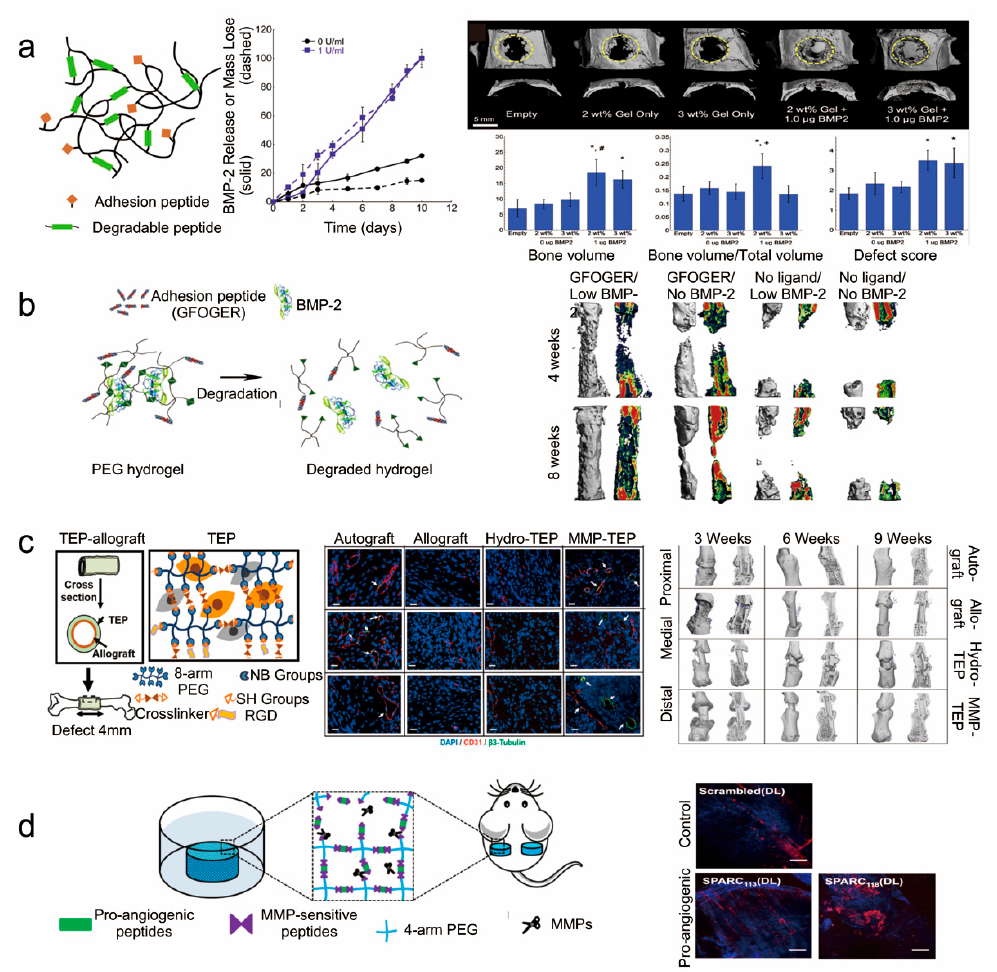
Figure 8. The MMP-cleavable peptides-based hydrogels for bone regeneration in vivo. ( a ) The MMP-cleavable peptides- based hydrogels were used to deliver growth factors (BMP-2) to promote bone healing [125]. Statistical significance ( p < 0.05): (*) compared to empty defect, (#) compared to the same hydrogel formulation without BMP-2, and (+) compared to 3 wt.% hydrogels with and without BMP-2. Reprinted with permission from Copyright © 2014 Elsevier B.V. ( b ) The MMP-cleavable peptides-based hydrogels with adhesive peptide (GFOGER) enhanced bone regeneration in